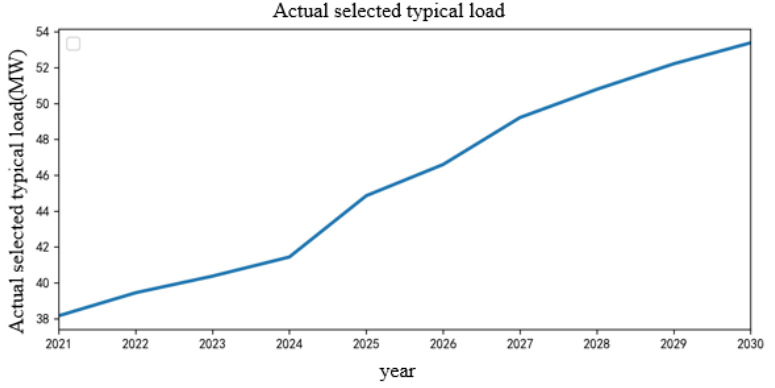
Figure 13. Actual selected typical load scenarios. Using the same method, the load scenarios of other nodes in the next 10 years are obtained, and the results are shown in Figure 14.